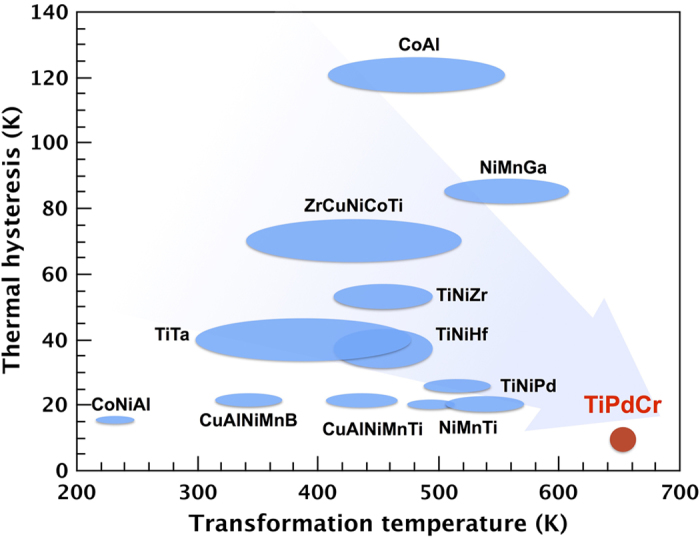
A comparison of the thermal hysteresis and transformation temperature for the bulk SMAs.The thermal hysteresis and transformation temperature values of CoAl27, ZrCuNiCoTi28, NiMnGa2930, TiNiHf31, TiNiPd3233, TiNiZr3435, TiTa36, CoNiAl37, ZnAuCu3, CuAlNiMnB38, TiNiCuPd14, CuAlNiMnTi26, and NiMnTi39 are collected from literatures.